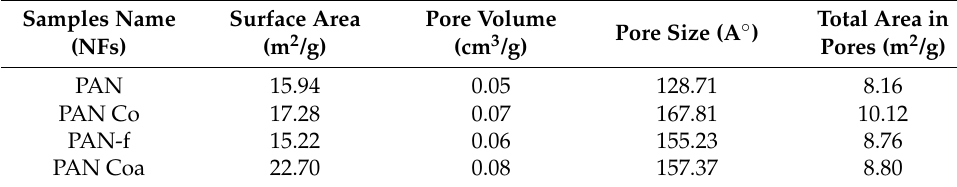
Table 1. Surface area and porosity of the NFs